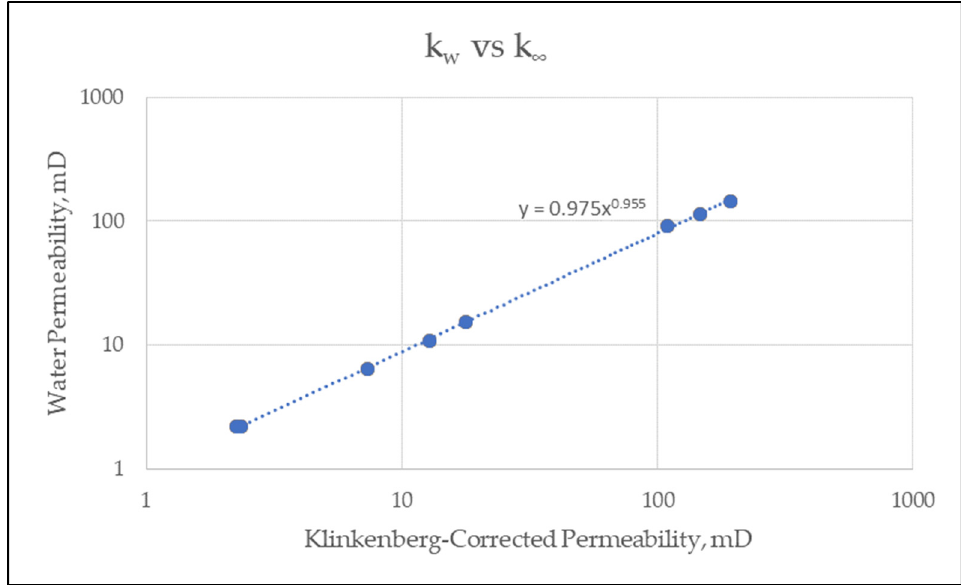
Figure 14. Graph of k w against k ∞ of eight PETRONS core